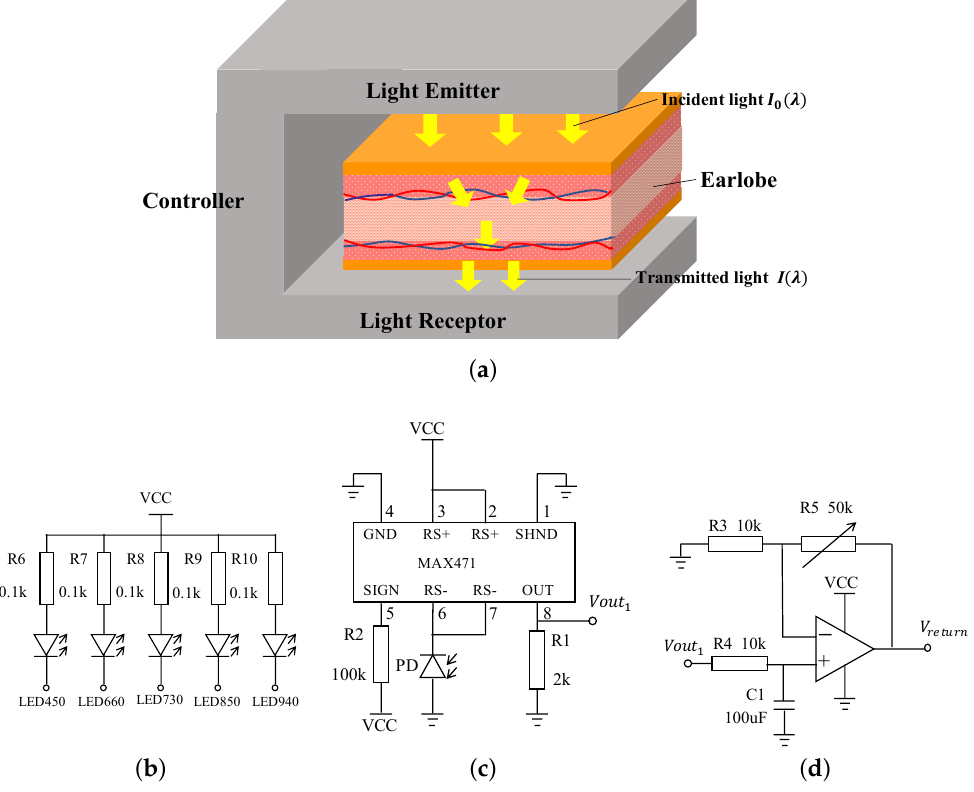
Figure 2. Structure and circuit design of the Earlight device: ( a ) Structural design; ( b ) Light emitter circuit; ( c ) Circuit of I-V Converter; ( d ) Filtering and amplifying circuit. VCC: Volt Current Condenser, GND: Ground, SHND: Shut down end, SIGN: Signal end, RS-: Resistance